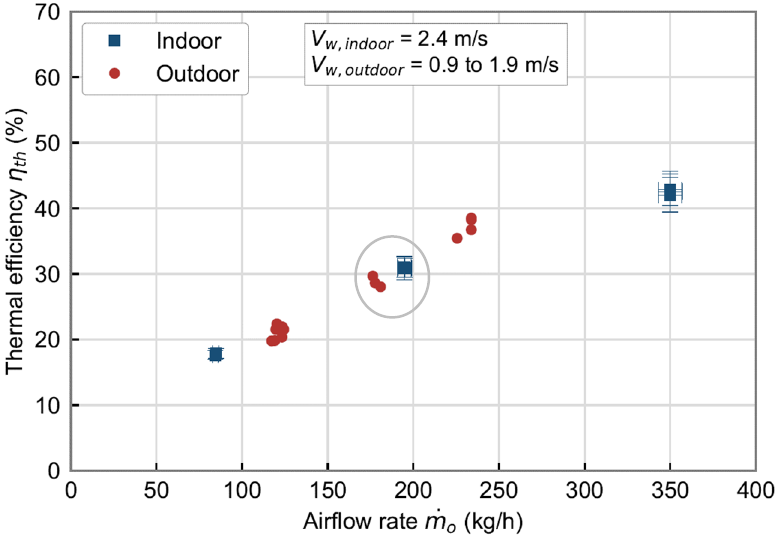
Figure 17. Indoor and outdoor thermal efficiency comparison as a function of specific airflow rate with T ∗ < 0.003 m 2 · K/W. Table 9. Indoor and outdoor thermal performance characterization comparison.